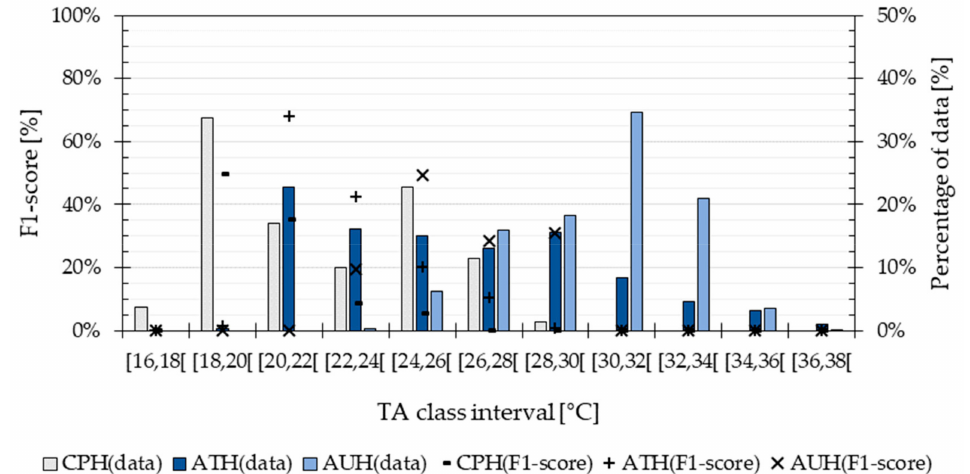
Figure 6. Distribution of the TA values and performance of the TA-prediction method when forecasting data from the building simulation model located in Athens (ATH), Copenhagen (CPH) and Abu Dhabi